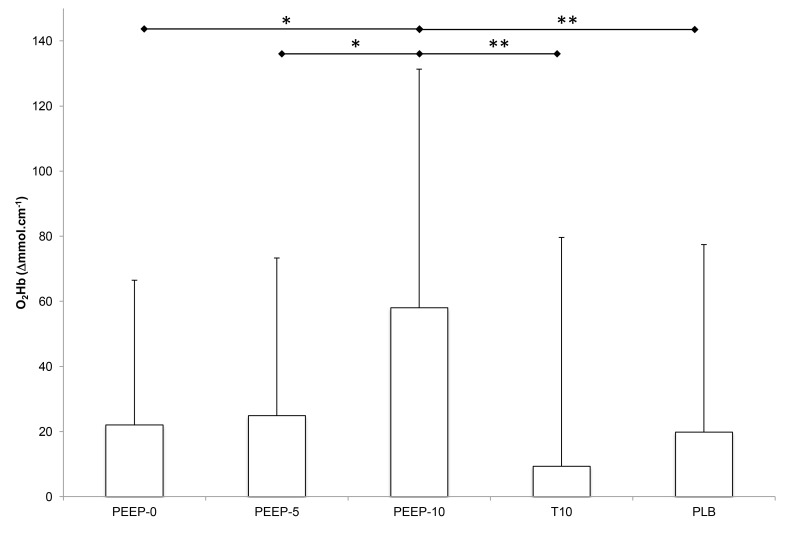
Changes in quadriceps oxyhemoglobin concentration (O2Hb, expressed as delta from the free breathing condition immediately before) in all experimental conditions.See Figure 1 for abbreviations. * significant difference between two conditions (*p < 0.05, **p < 0.01).